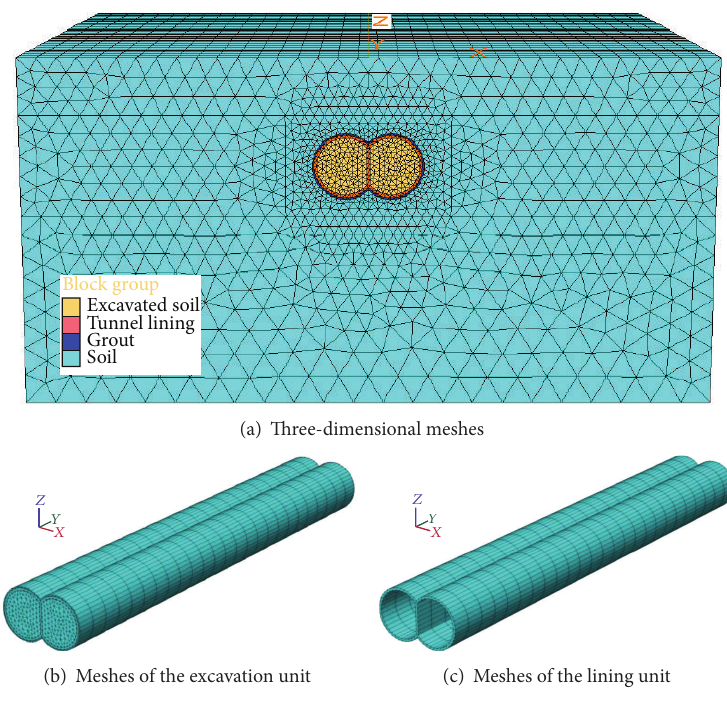
Figure 6: Meshes of the computing